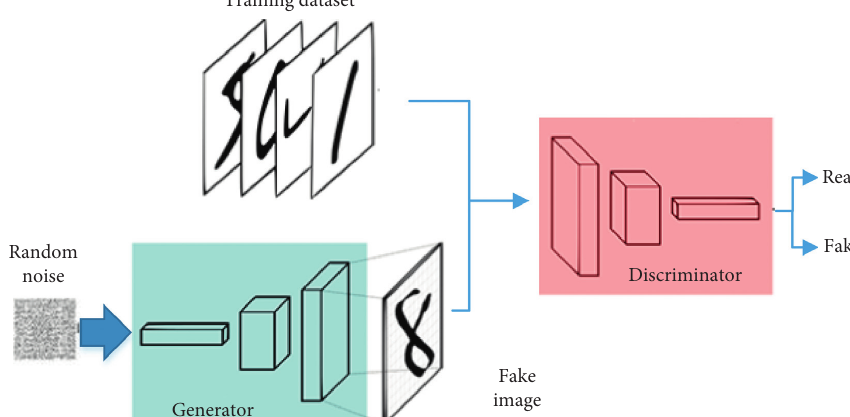
Figure 4: Architecture of a GAN model to generate samples of handwritten digital number images, where we can notice that random noise is introduced as input for